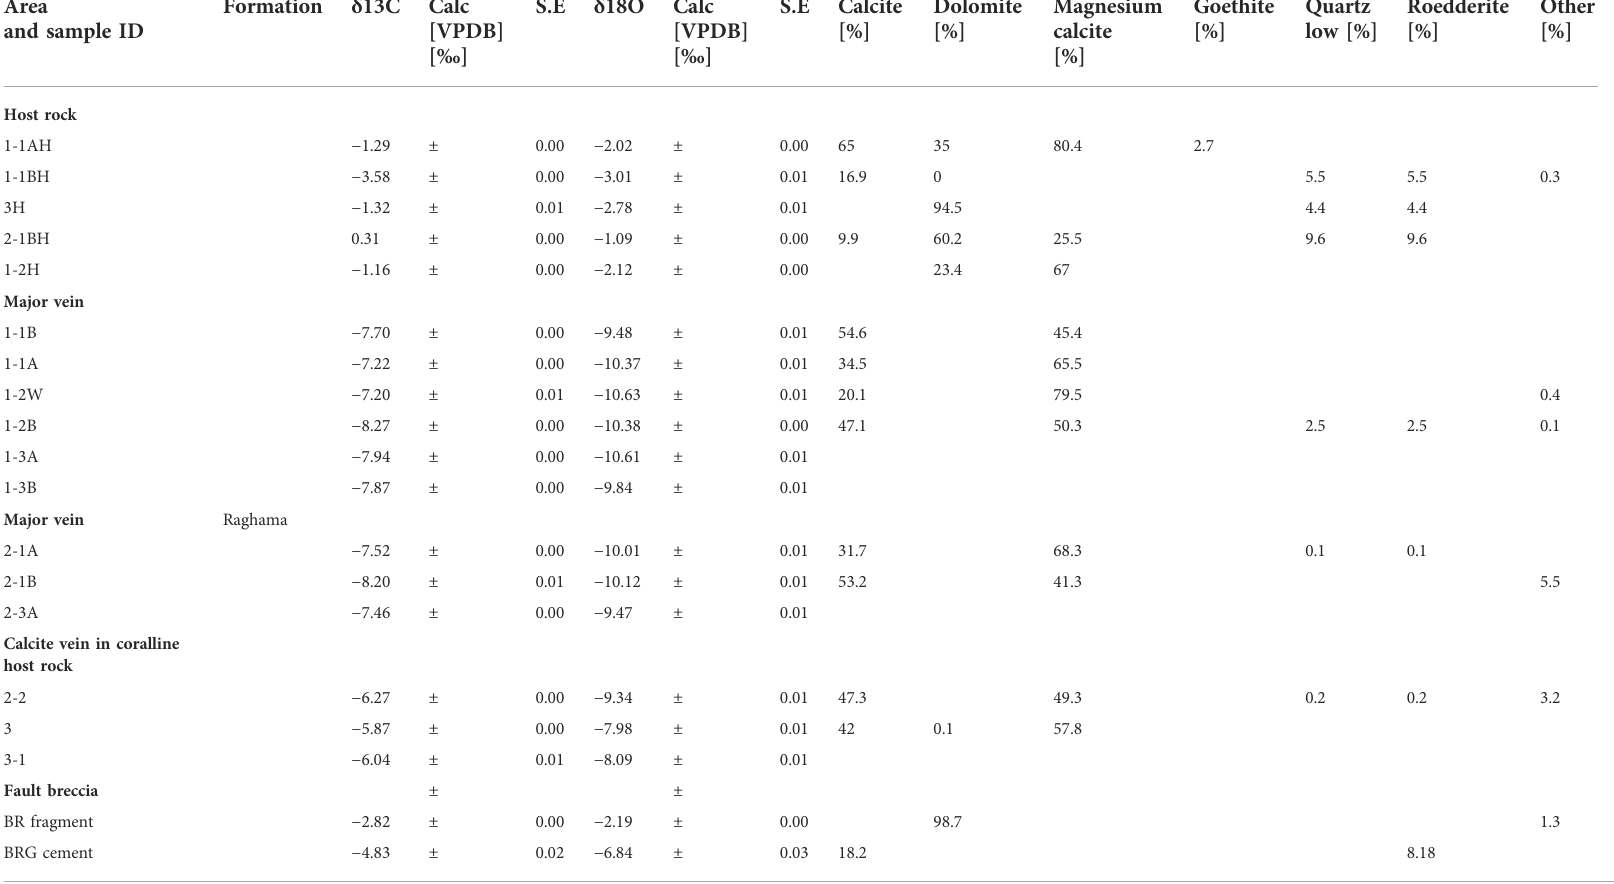
TABLE 1 Summary of isotope and XRD analysis of the study